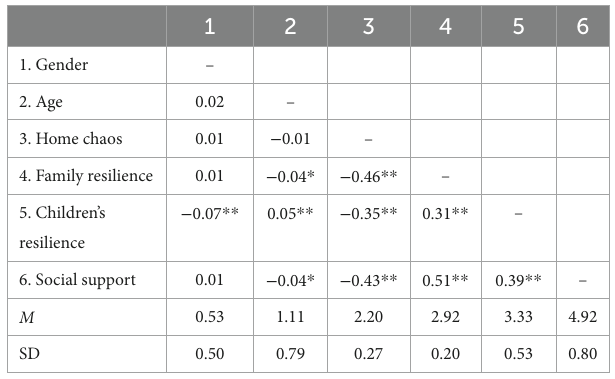
TABLE 2 Descriptive statistics and correlation matrix for each variable ( N =